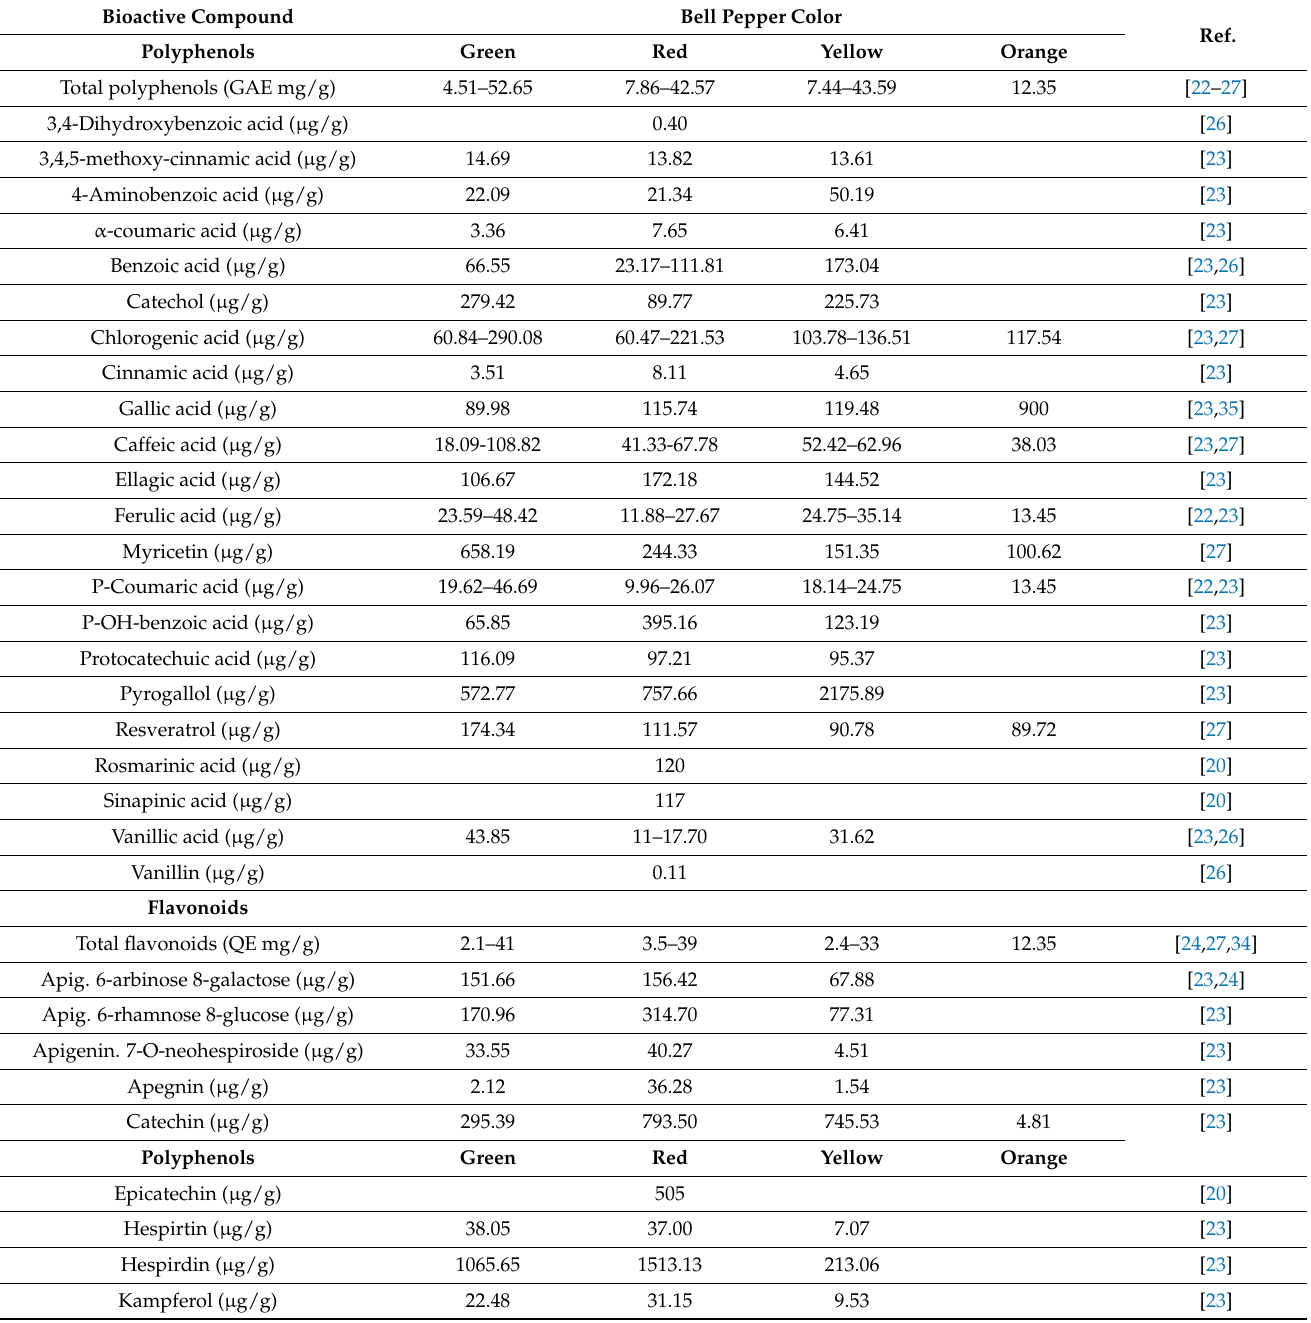
Table 2. Polyphenol and flavonoid content in bell pepper